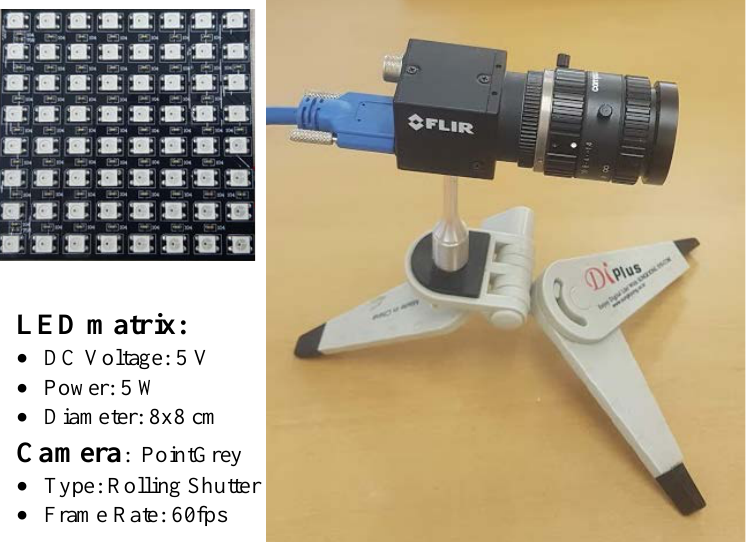
Figure 4. The theoretical relationship between Pixel Eb/No and image amplitude.